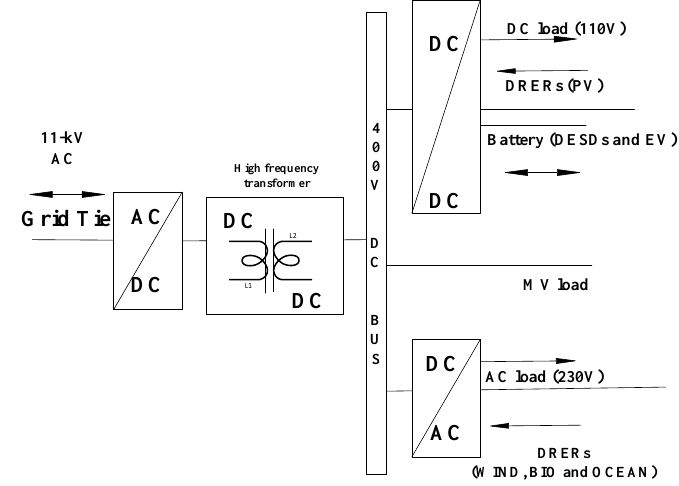
Figure 3. Block diagram of a distribution-solid state transformer (SST).